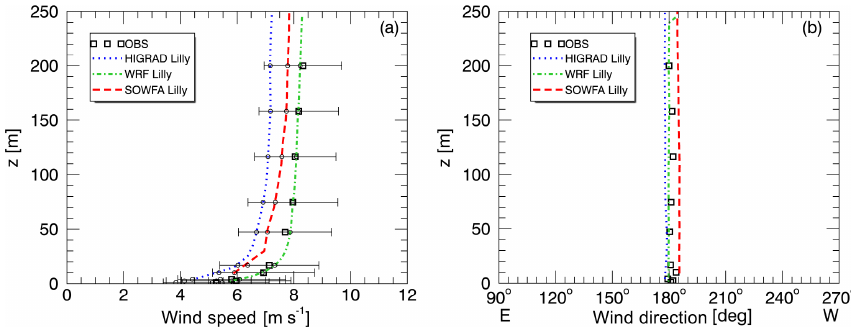
Figure 14. Measured and simulated wind speed (a) and wind direction (b) using all three solvers, each with its optimal aspect ratio, during the convective case